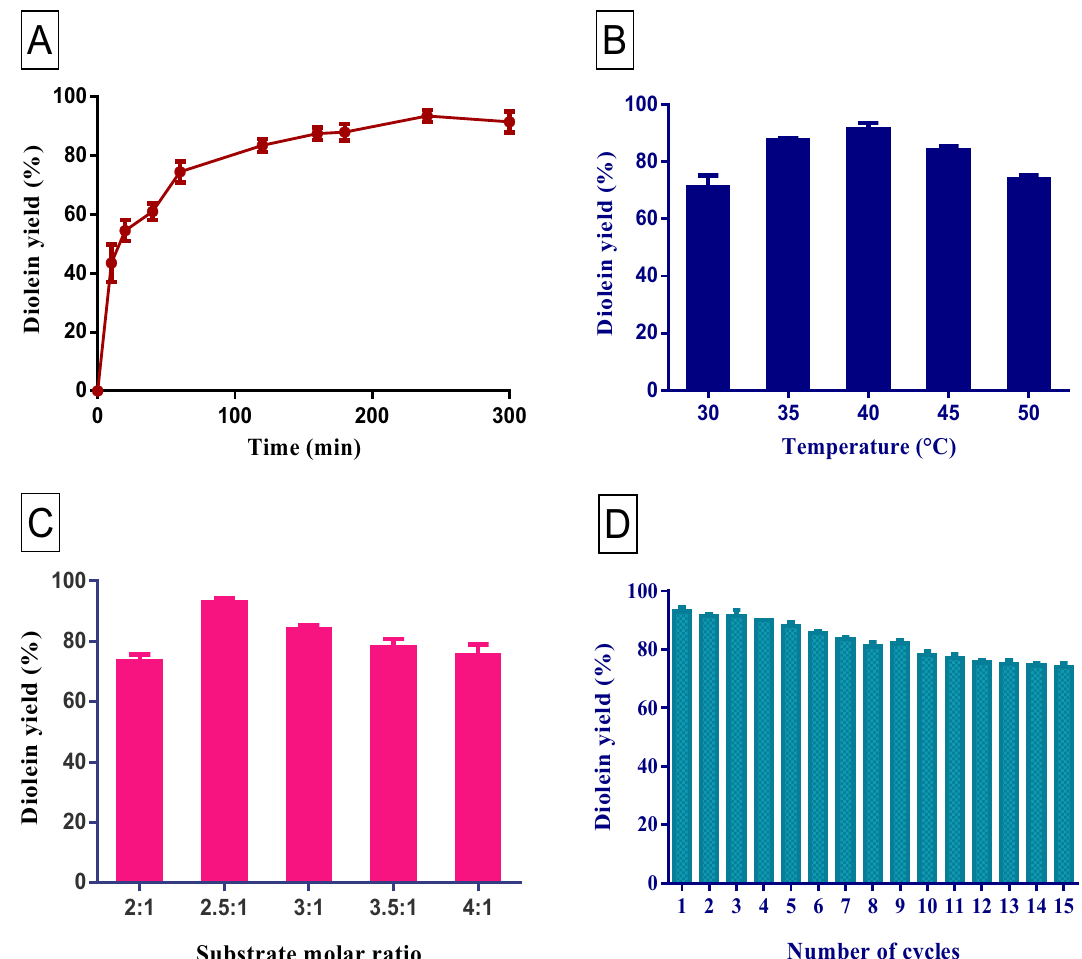
Figure 10. Effect of process parameters for the conversion of 1,3-diolein synthesis via esterification of oleic acid with monoolein catalyzed by immobilized Porcine pancreatic lipase. ( A ) The time course percentage conversion. ( B ) Temperature. ( C ) Substrate molar ratio. ( D ) Reusability